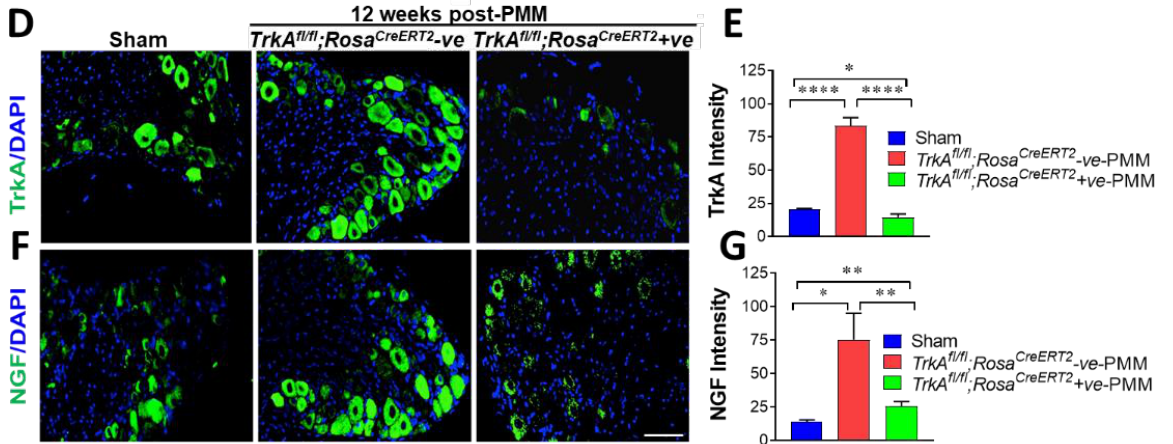
Figure 1. Global deletion of TrkA in mice relieved OA-associated hypersensitivity to pain and reduced expression of TrkA and NGF in the DRG but did not improve knee joint pathology with OA progression. ( A ) Development of mechanical allodynia (von Frey filament testing) in the ipsilateral hind paw, comparing TrkA fl/fl ;Rosa CreERT2 -negative ( n = 11) and TrkA fl/fl ;Rosa CreERT2 -positive ( n = 5) mice following PMM. ( B ) Histological assessment for proteoglycan depletion by Safranin-O fast green staining (×20). Each knee shown represents a group of mice ( n = 4). ( C ) Severity of articular cartilage degradation was graded using the Osteoarthritis Research Society International (OARSI) scoring system. Values are mean ± SEM. Global deletion of TrkA in mice resulted in reduced expression of NGF. Immunofluorescence images of TrkA ( D ) and NGF ( F ) in the lumbar DRG (L3-L5) harvested at 12 weeks after PMM showed significant reduction of both TrkA and NGF in TrkA fl/fl ;Rosa CreERT2 -positive mice. The quantification of TrkA intensity ( E ) and NGF intensity ( G ) showed deletion of TrkA significantly reduced NGF in DRG ( F , G ). Values are mean ± SEM. * p < 0.05, ** p < 0.01, *** p < 0.001, **** p < 0.0001, ns: not significant. p = 0.742 (sham), p = 0.582 (PMM). Scale bar: 100 µ